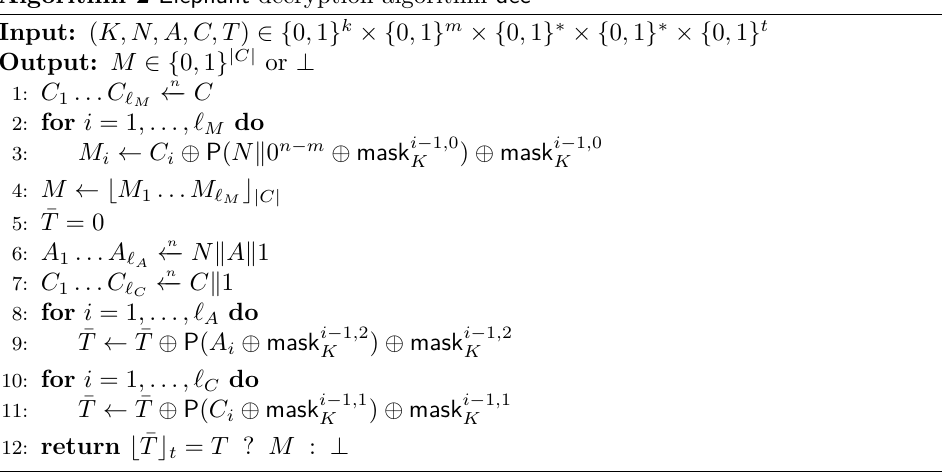
Algorithm 2 Elephant decryption algorithm